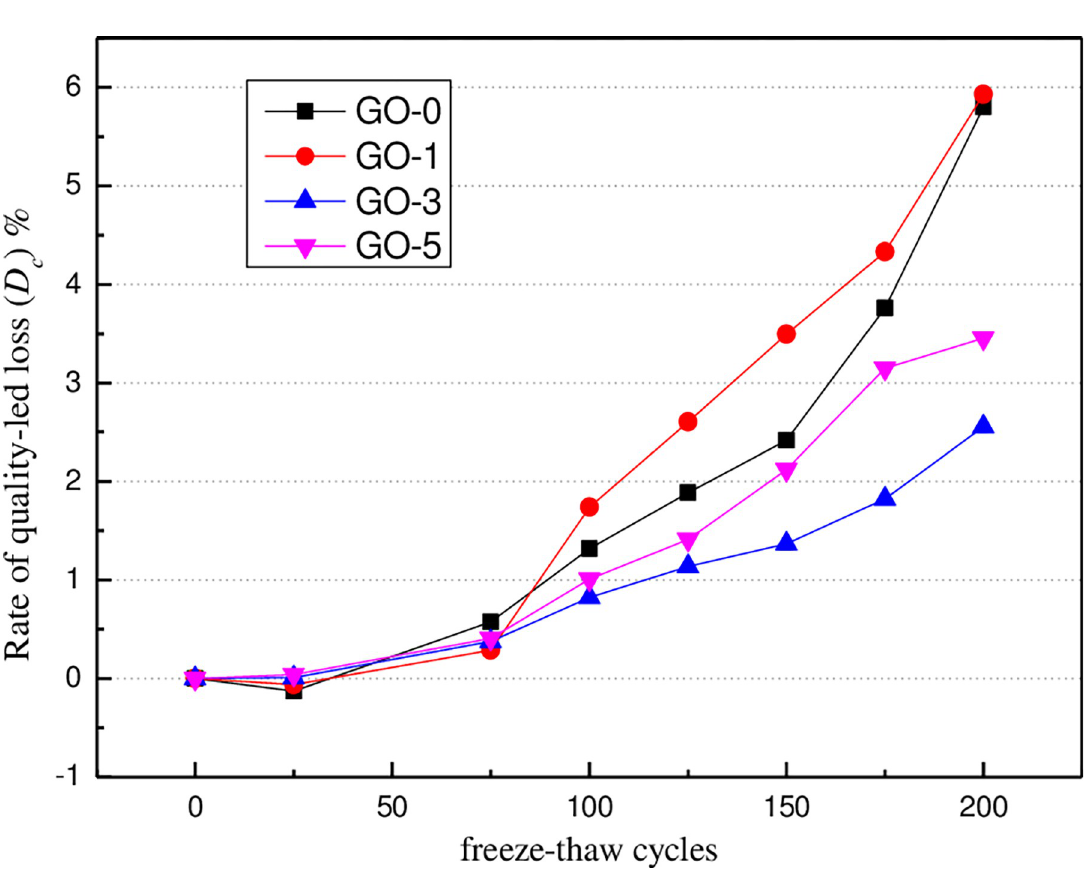
Fig 11. Changes in mass loss of GO-modified concrete under different freeze-thaw